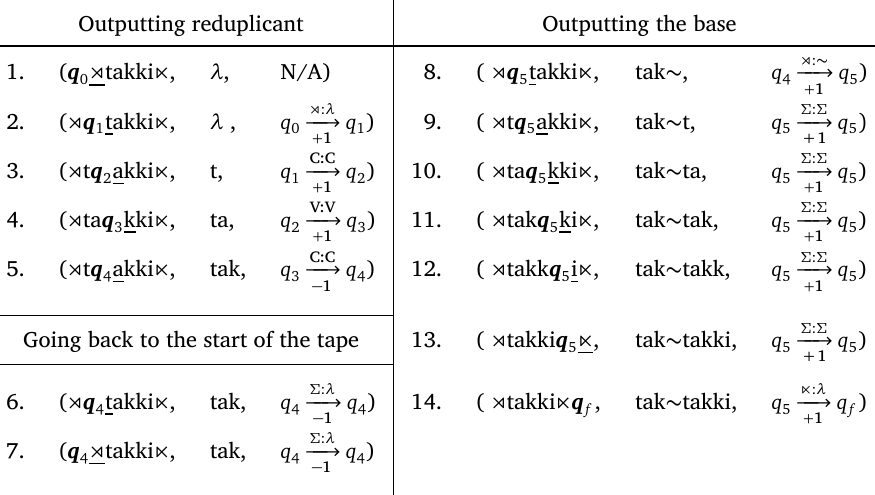
Table 2: Derivation of /takki/ ! [tak (cid:24) takki] Outputting